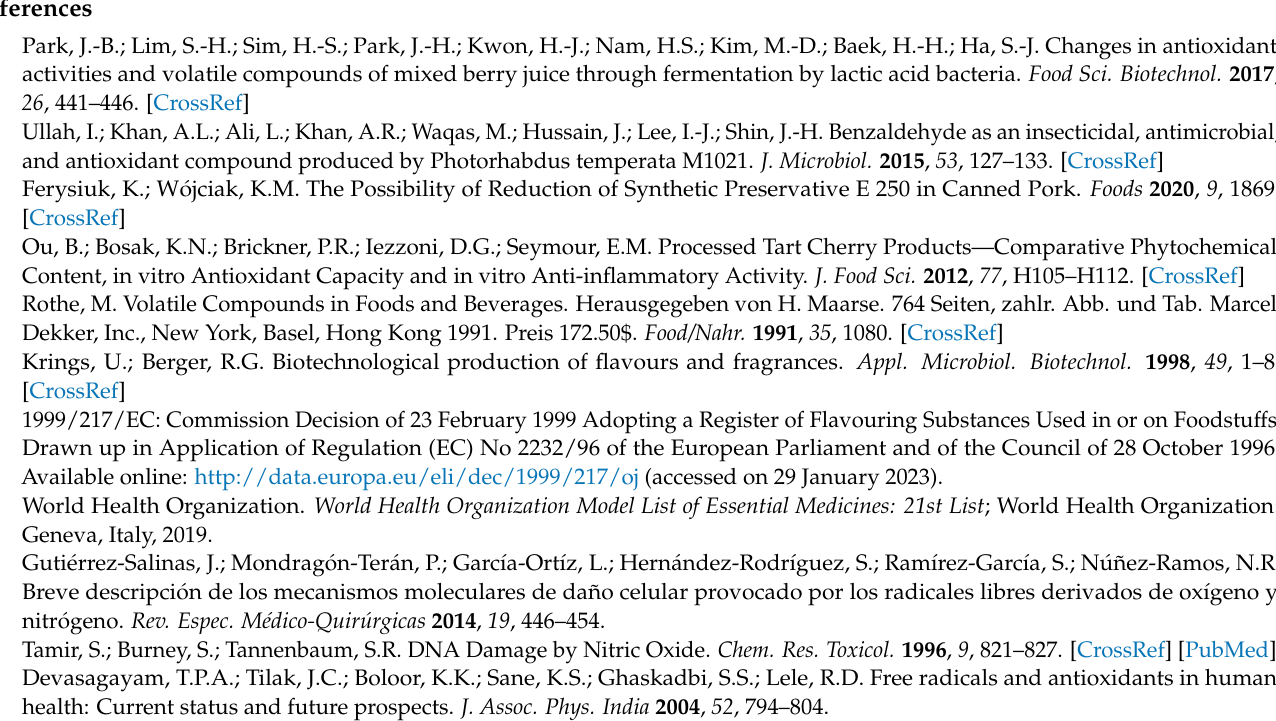
of the rational fit and reaction constants obtained for each aldehyde. Table S7: Reaction constants for the aldehydes studied. together with the bibliographic values obtained for the parameter σ . Figure S1. Influence of [pHBZH] (left) and [HOONO] (right) upon the initial rate at pH = 2. I = 0.1 M and T = 25 ◦ C. Figure S2. Influence of [pMeBZH] (left) and [HOONO] (right) upon the initial rate at pH = 2. I = 0.1 M and T = 25 ◦ C. Figure S3. Influence of [pMoxBZH] (left) and [HOONO] (right) upon initial rate at pH = 2. I = 0.1 M and T = 25 ◦ C. Figure S4. Influence of [oHBZH] (left) and [HOONO] (right) upon the initial rate at pH2. I = 0.1 M and T = 25 ◦ C. Figure S5. Influence of [pTFBZH] (left) and [HOONO] (right) upon the initial rate at pH2. I = 0.1 M and T = 25 ◦ C. Figure S6. Influence of pH upon initial reaction rate [RBZH] = 4.00 × 10 − 5 M; [ONOO − ] = 8.00 × 10 − 5 M; I = 0.1 M; Tª = 25 ◦ C. Figure S7: Comparison of the 1H-NMR spectrum obtained from the liquid fraction vs. the 1H-NMR spectrum of benzyl alcohol. 1H-NMR spectrum of benzyl alcohol. Figure S8: Comparison of 1 H-NMR spectrum obtained from the liquid fraction vs. 1 H-NMR spectrum of benzyl alcohol. 1 H- NMR spectrum of benzoic acid. Reaction mechanism in acid and basic media. Figure S9: Graphical representation of the Hammett equation for k 4 nucleophilic attack. Also, the theoretical rate equation deduction according to has been included